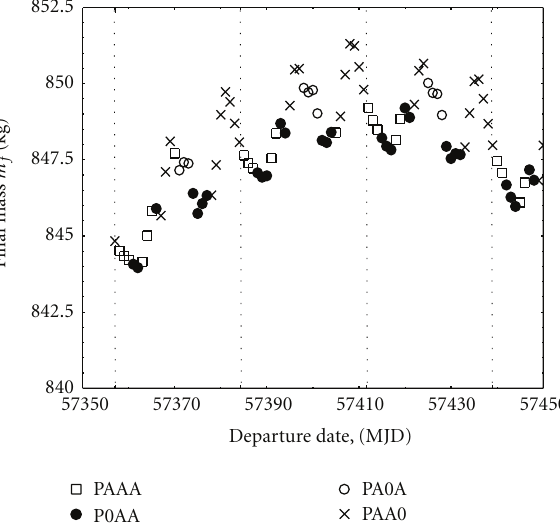
Figure 8: Switching structure for 4.5-revolution 8N